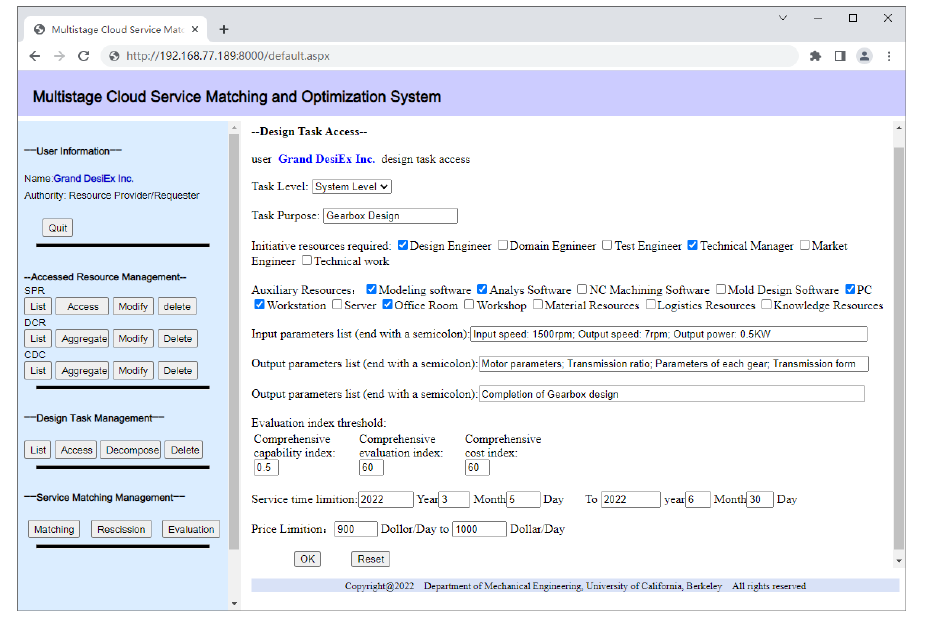
Figure 17. The interface of design task access. Table 1. Candidate cloud service module.